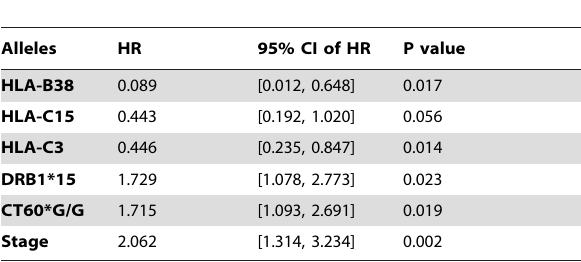
Table 5. Multivariate overall survival (OS) analysis with stage